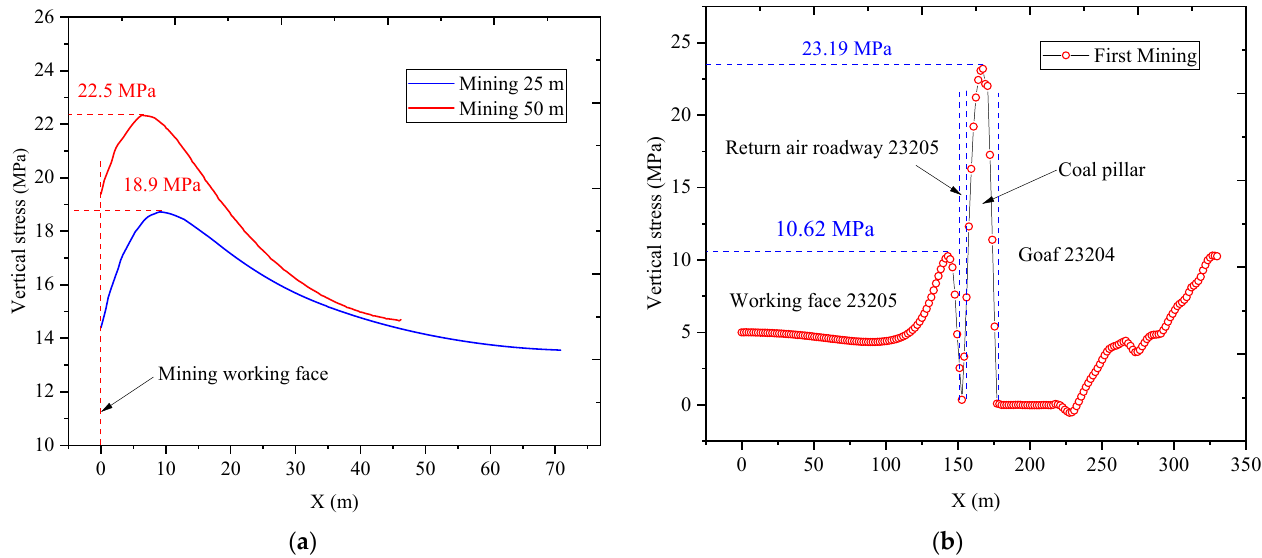
Figure 10. Stress evolution law of surrounding rock during the first mining: ( a ) the vertical stress distribution at 2 m from the roof in the middle of the coal pillar in the front of the working face with different mining distances; ( b ) the vertical stress distribution in the middle sidewalls of RAR 23205.